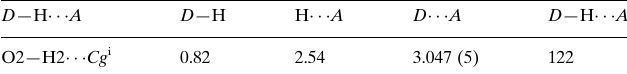
Hydrogen-bond geometry (A˚ , (cid:2) ). Cg is the centroid of benzene ring